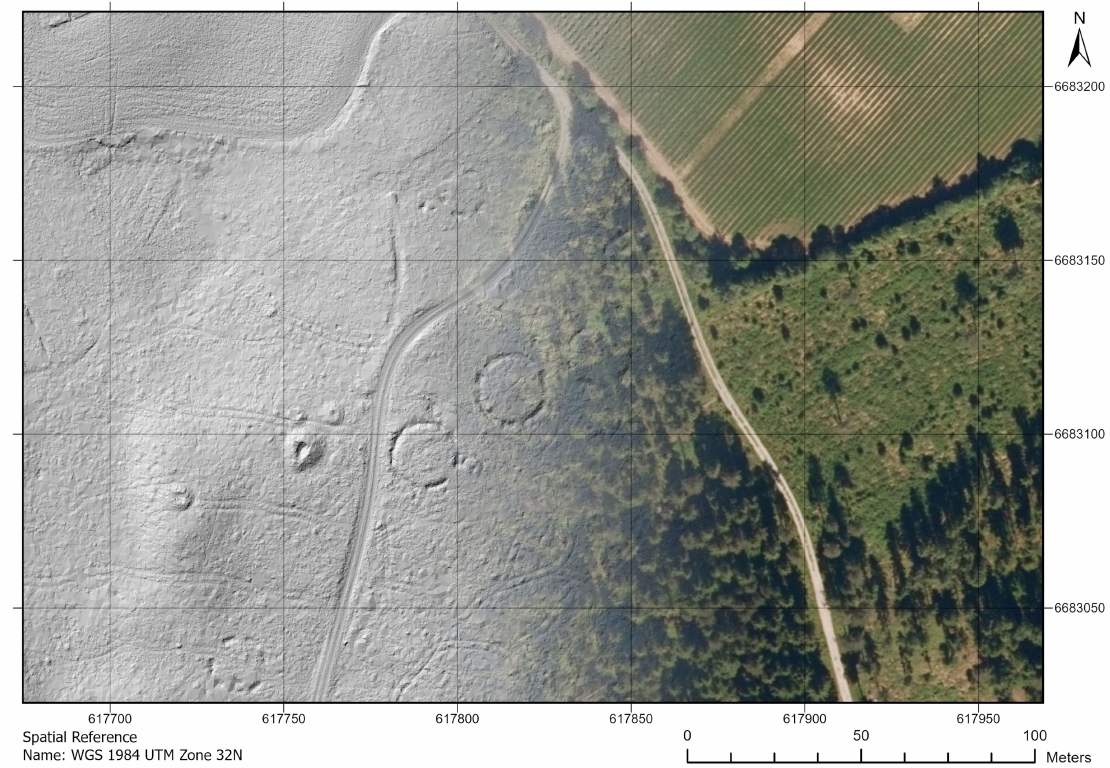
Figure 2. A landscape section from a rural district north of Oslo in SE-Norway seen from aloft. The right-hand part of the image is an aerial photo and the left-hand part a LiDAR generated digital terrain model. The image exemplifies a forest holding a large number of cultural features, in this case charcoal kilns, grave mounds and (hollow) roads. Illustration by Magnar Mojaren Gran, NTNU University